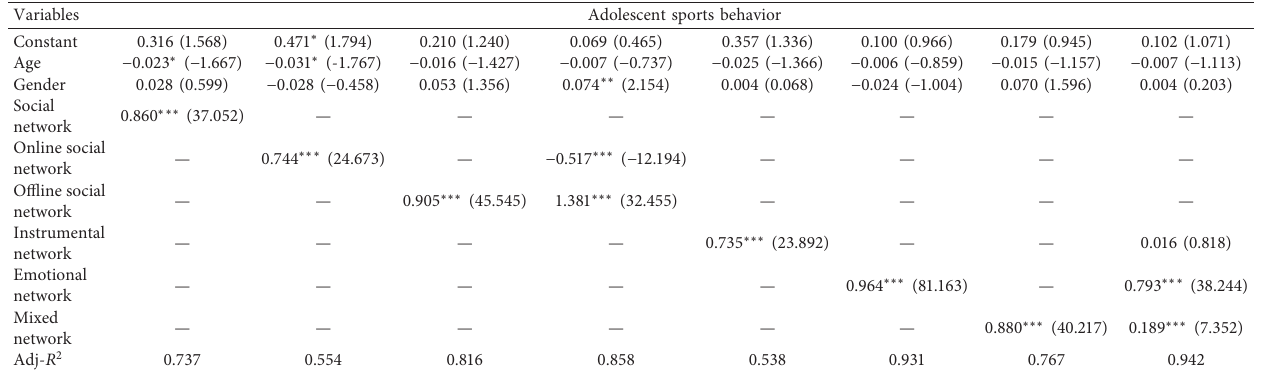
Figure 2: Statistic of adolescent social networks and sports behavior. Table 2: Estimated results of the influence of social network on adolescent sports